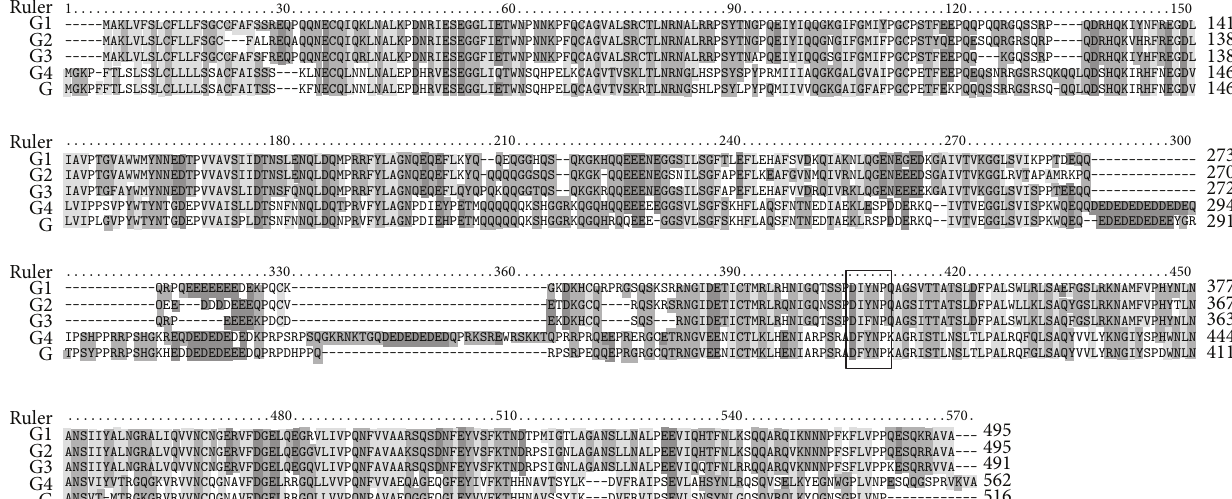
------------QRPQEEEEEEEDEKPQCK----------------------------------GKDKHCQRPRGSQSKSRRNGIDETICTMRLRHNIGQTSSPDIYNPQAGSVTTATSLDFPALSWLRLSAEFGSLRKNAMFVPHYNLN 377 ------------OEE---DDDDEEEQPQCV----------------------------------ETDKGCQ----RQSKRSRNGIDETICTMRLRQNIGQNSSPDIYNPQAGSITTATSLDFPALWLLKLSAQYGSLRKNAMFVPHYTLN 367 ------------QRP------EEEEKPDCD----------------------------------EKDKHCQ----SQS---RNGIDETICTMRLRHNIGQTSSPDIFNPQAGSITTATSLDFPALSWLKLSAQFGSLRKNAMFVPHYNLN 363 IPSHPPRRPSHGKREQDEDEDEDEDKPRPSRPSQGKRNKTGQDEDEDEDEDQPRKSREWRSKKTQPRRPRQEEPRERGCETRNGVEENICTLKLHENIARPSRADFYNPKAGRISTLNSLTLPALRQFQLSAQYVVLYKNGIYSPHWNLN 444 TPSYPPRRPSHGKHEDDEDEDEEEDQPRPDHPPQ------------------------------RPSRPEQQEPRGRGCQTRNGVEENICTMKLHENIARPSRADFYNPKAGRISTLNSLTLPALRQFGLSAQYVVLYRNGIYSPDWNLN 411